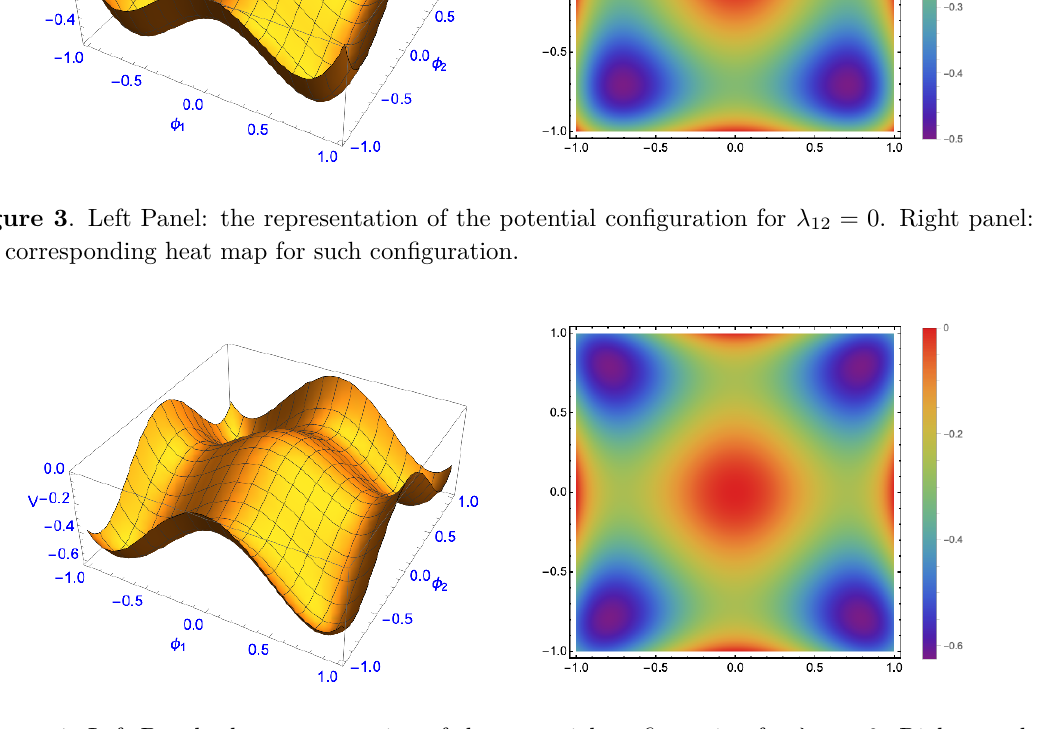
Figure 4 . Left Panel: the representation of the potential configuration for λ 12 < 0 . Right panel: the corresponding heat map for such